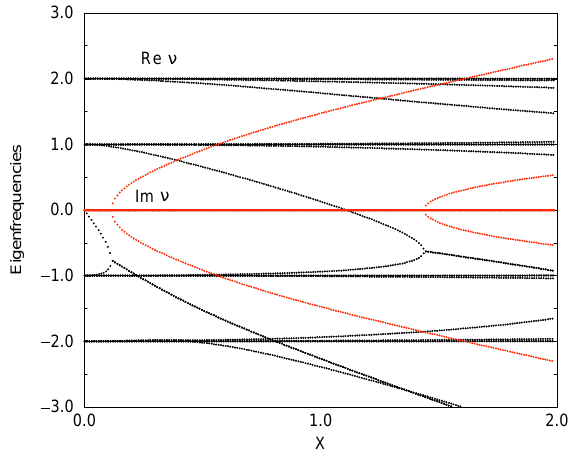
FIG. 3. (Color) Eigenfrequencies (real parts in black, imaginary in red) of transverse oscillations versus (cid:88) (cid:173) (cid:78)(cid:101) (cid:50) b (cid:87) (cid:121) (cid:50) p (cid:50) g (cid:109)(cid:99) (cid:50) (cid:84) (cid:48) . The parameter (cid:80) s (cid:173) (cid:50)